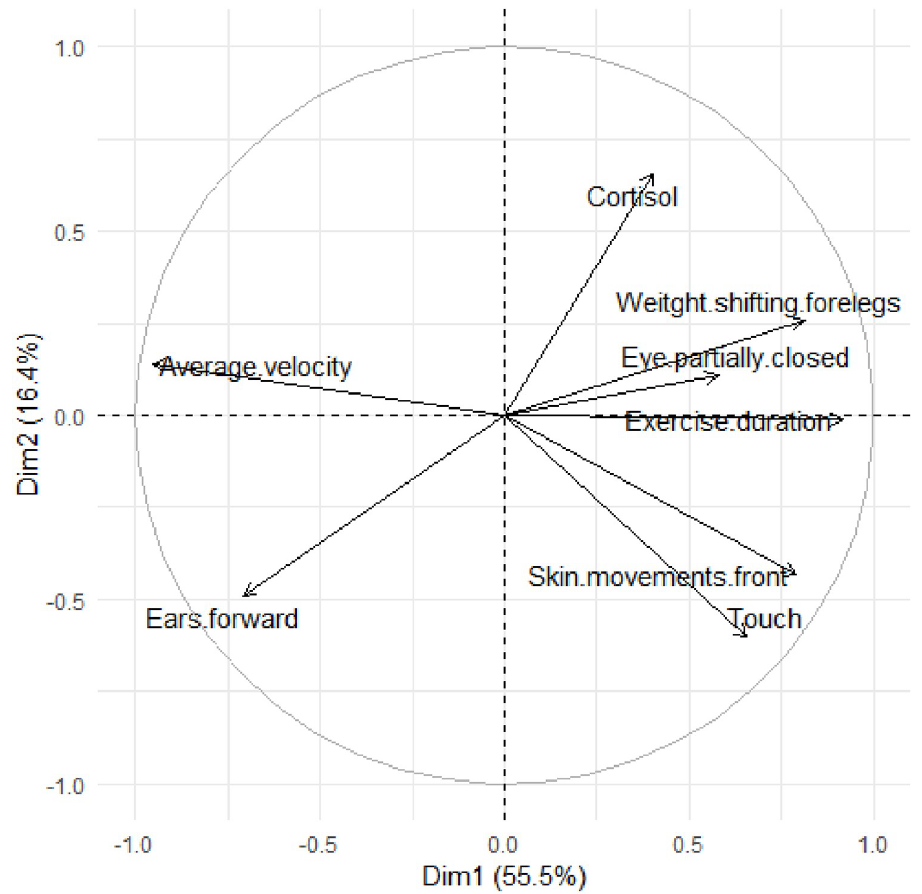
Fig 2. Projections of the loading values in the two dimensions of the Principal Component Analysis performed with the selected variables of the workload variables (exercise duration and average velocity), and the pre- and post-workday differences of facial expressions (eye partially closed, eye white showing and ears forward), other behaviours (weight-shifting forelegs, skin movements front, and touch) and physiological variable (cortisol) assessed in 14 ranch horses.